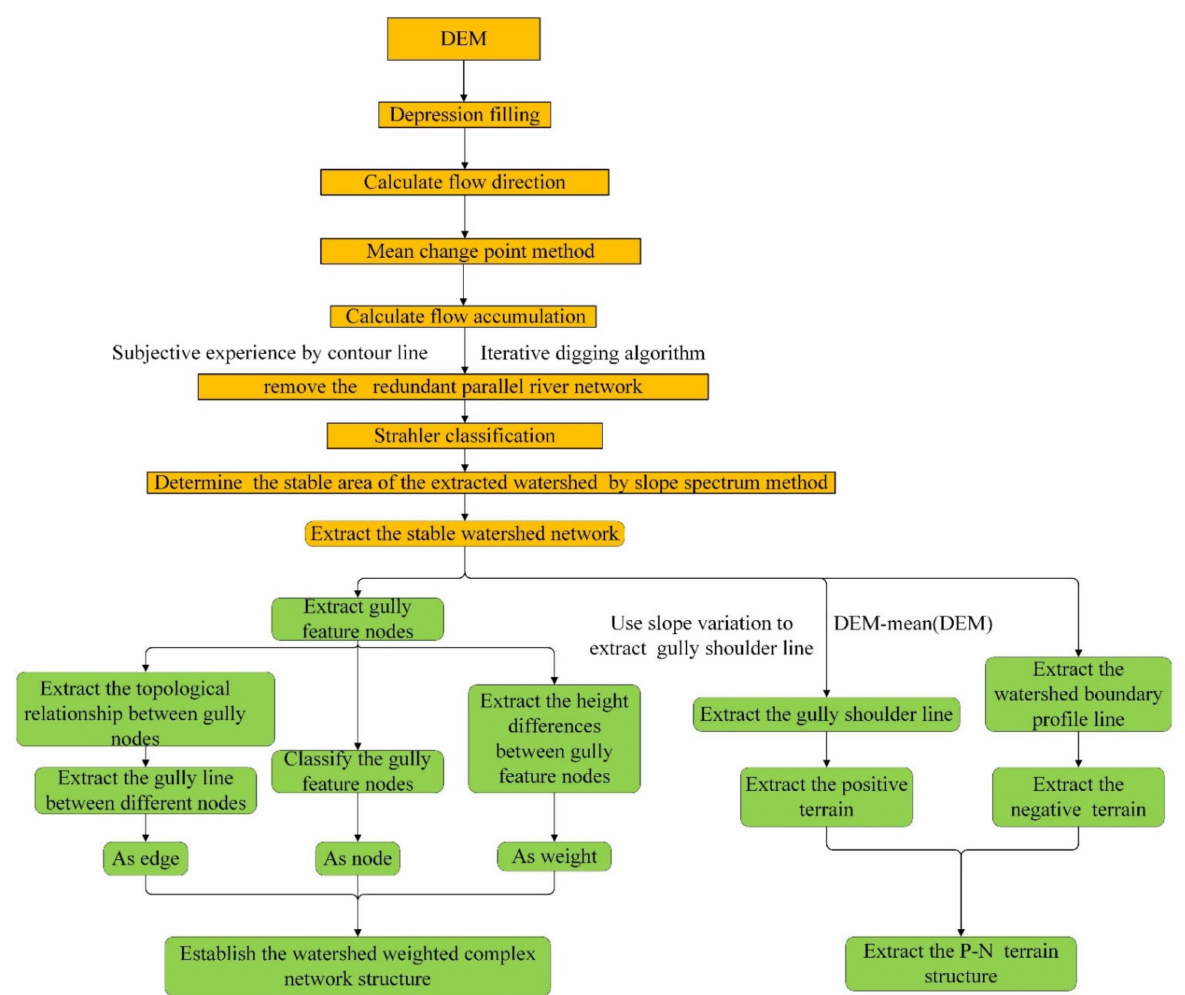
Figure 3. Technical route for constructing the two kinds of watershed spatial